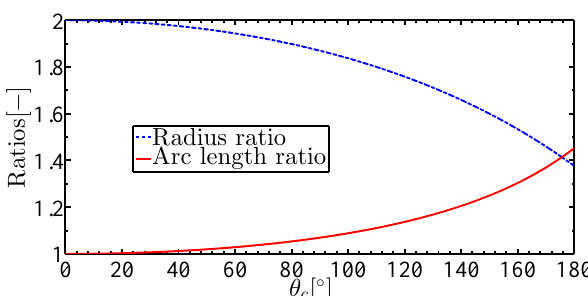
Figure 3: Arc length ratio and radius